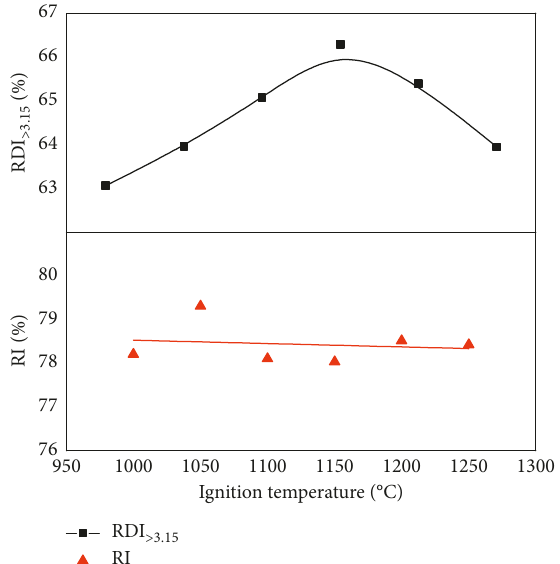
3.15 at different ignition >